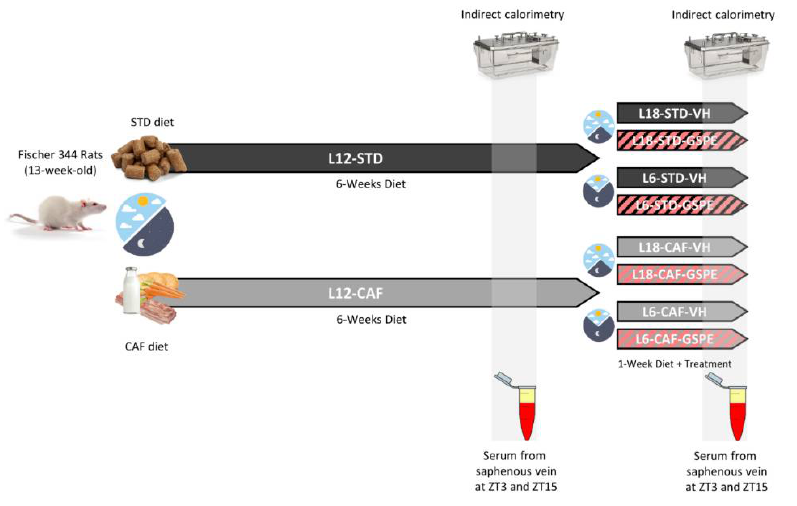
Figure 1. Experimental design to evaluate the effect of GSPE after an abrupt disturbance of the photoperiod. STD- and CAF-fed rats were switched to a new light–dark cycle and VH or GSPE were administered to the animals. STD, Standard diet-fed rats; CAF, Cafeteria diet-fed rats; VH, rats administered vehicle; GSPE, rats administered 25 mg/kg grape seed proanthocyanidin-rich extract; L12, standard photoperiod 12 h light per day; L18, long photoperiod 18 h light per day; L6, short photoperiod 6 h light per day.